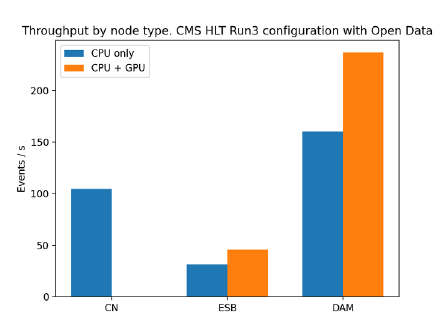
Figure 5: Results running CMS HLT Run 3 configuration using Open Data on di ff erent compute modules of the